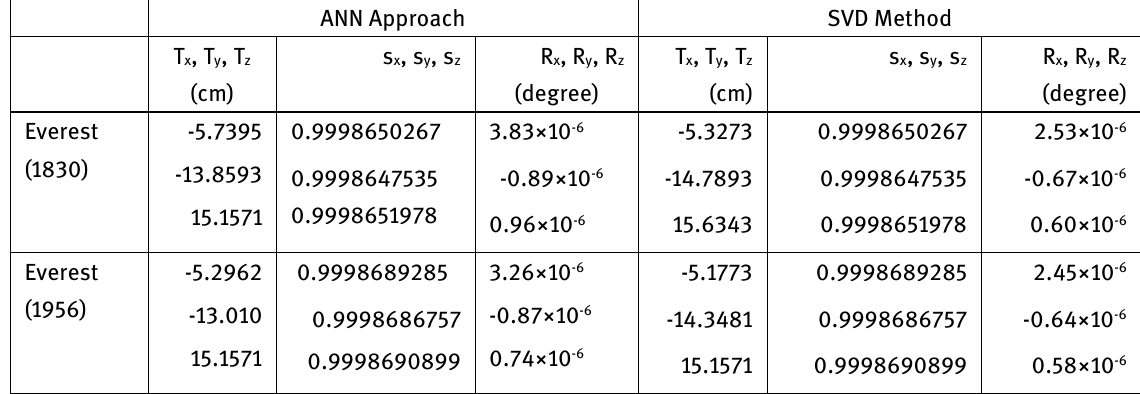
Table 1: Estimated parameters form WGS-84 to Everest datums ANN Approach SVD Method